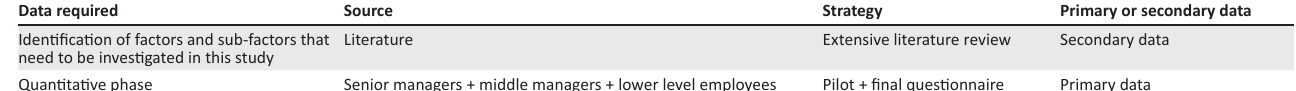
TABLE 2: Summary of quantitative data collection sources and